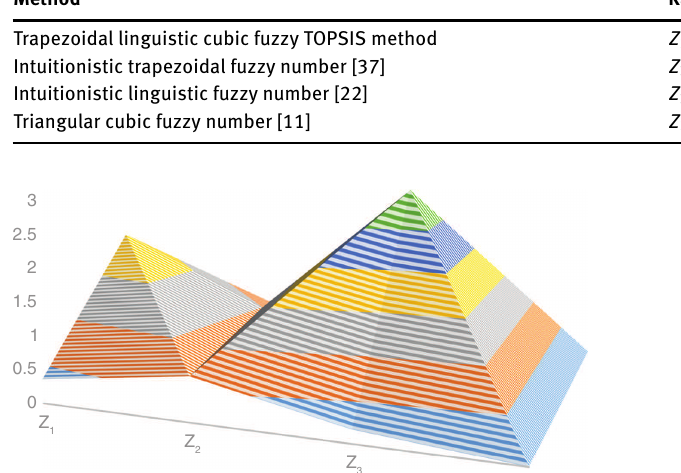
Figure 2: Ranking